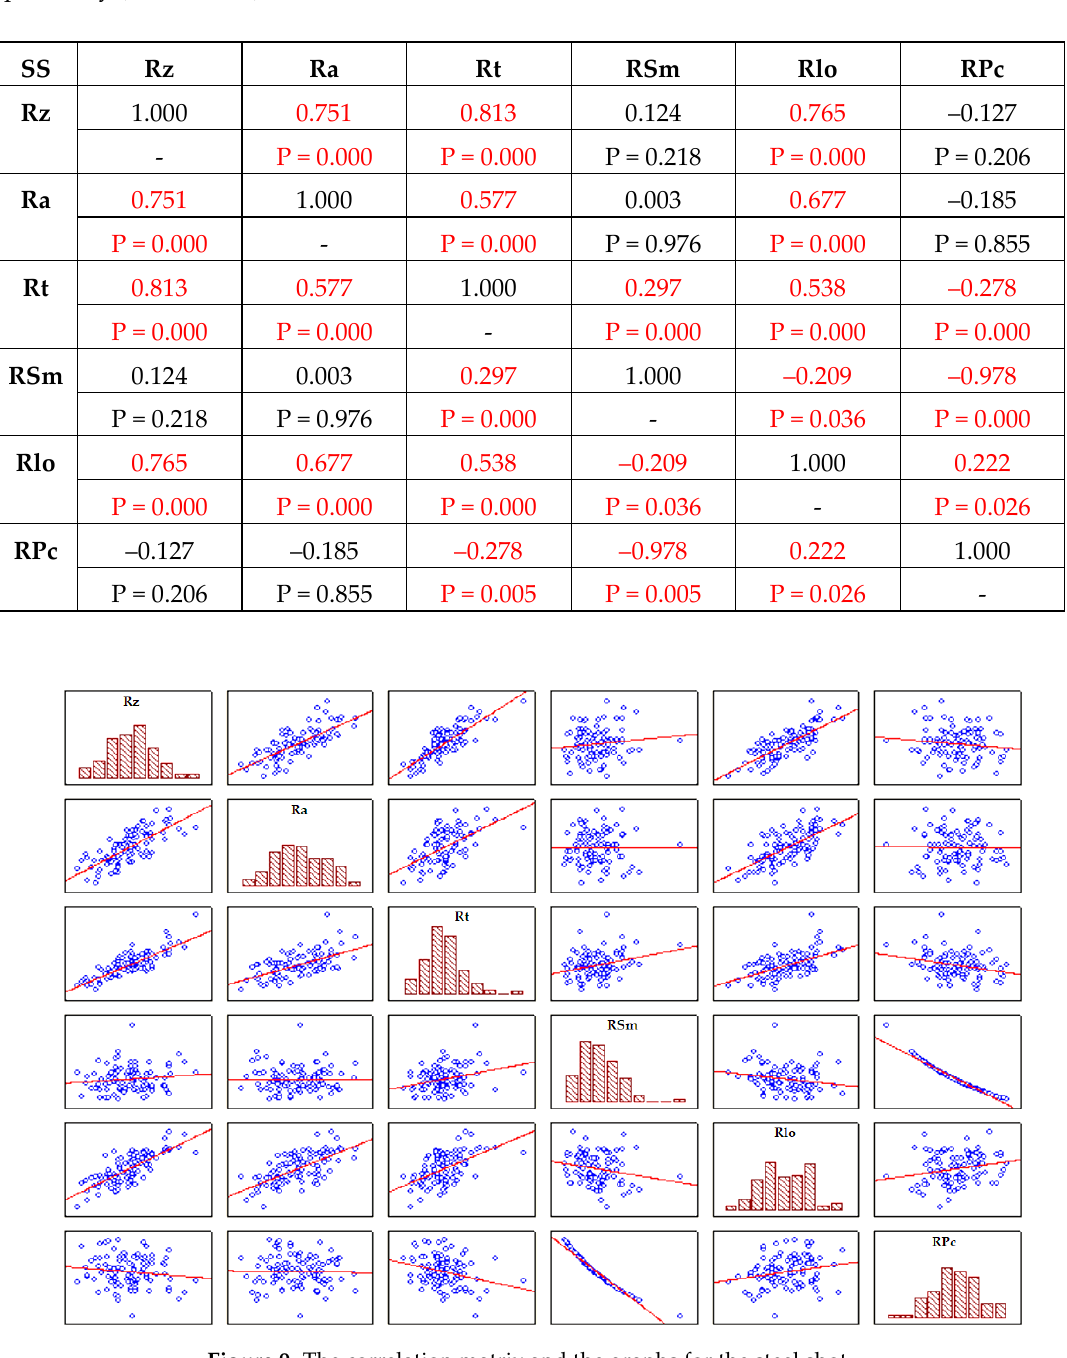
Figure 9. The correlation matrix and the graphs for the steel shot. Correlation matrix and graphs of corundum (Figure 10) show a significant correlation between the observed parameters except for Ra-RSm and Ra-RPc. There is a very close dependence between RPc-RSm. Rz-Ra and Rz-Rt feature a high dependence. Rz-Ra and Rz-Rt feature a strong direct dependence, while RPc-RSm feature a strong indirect dependence. There is an indirect dependence between RPc and other parameters, with the exception of Rlo where there is no